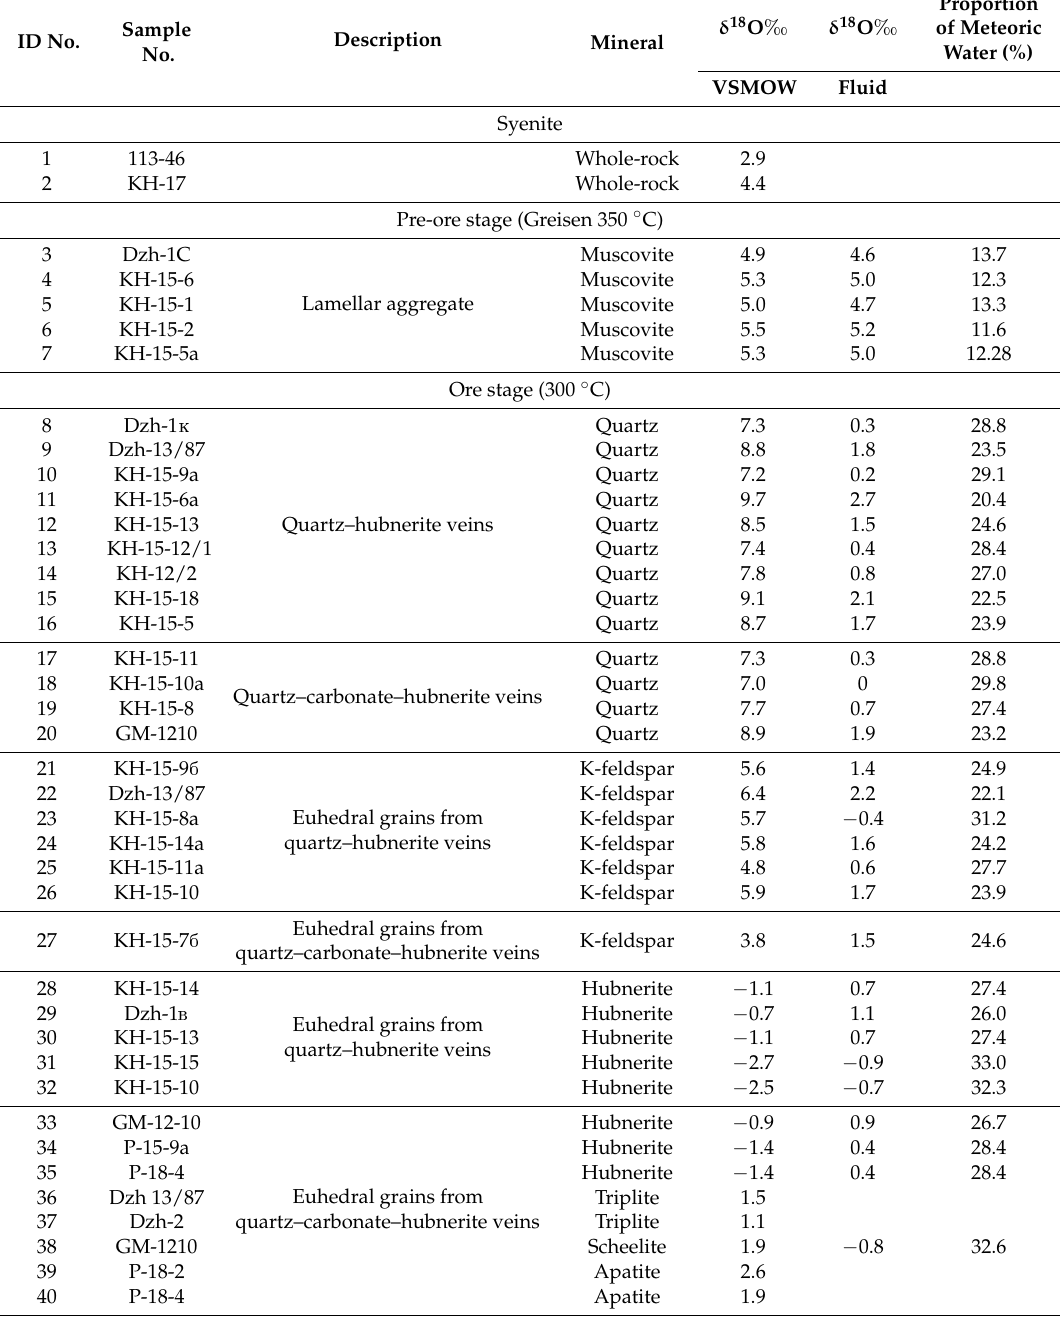
Table 2. The δ 18 O values in minerals from the Kholtoson deposit.